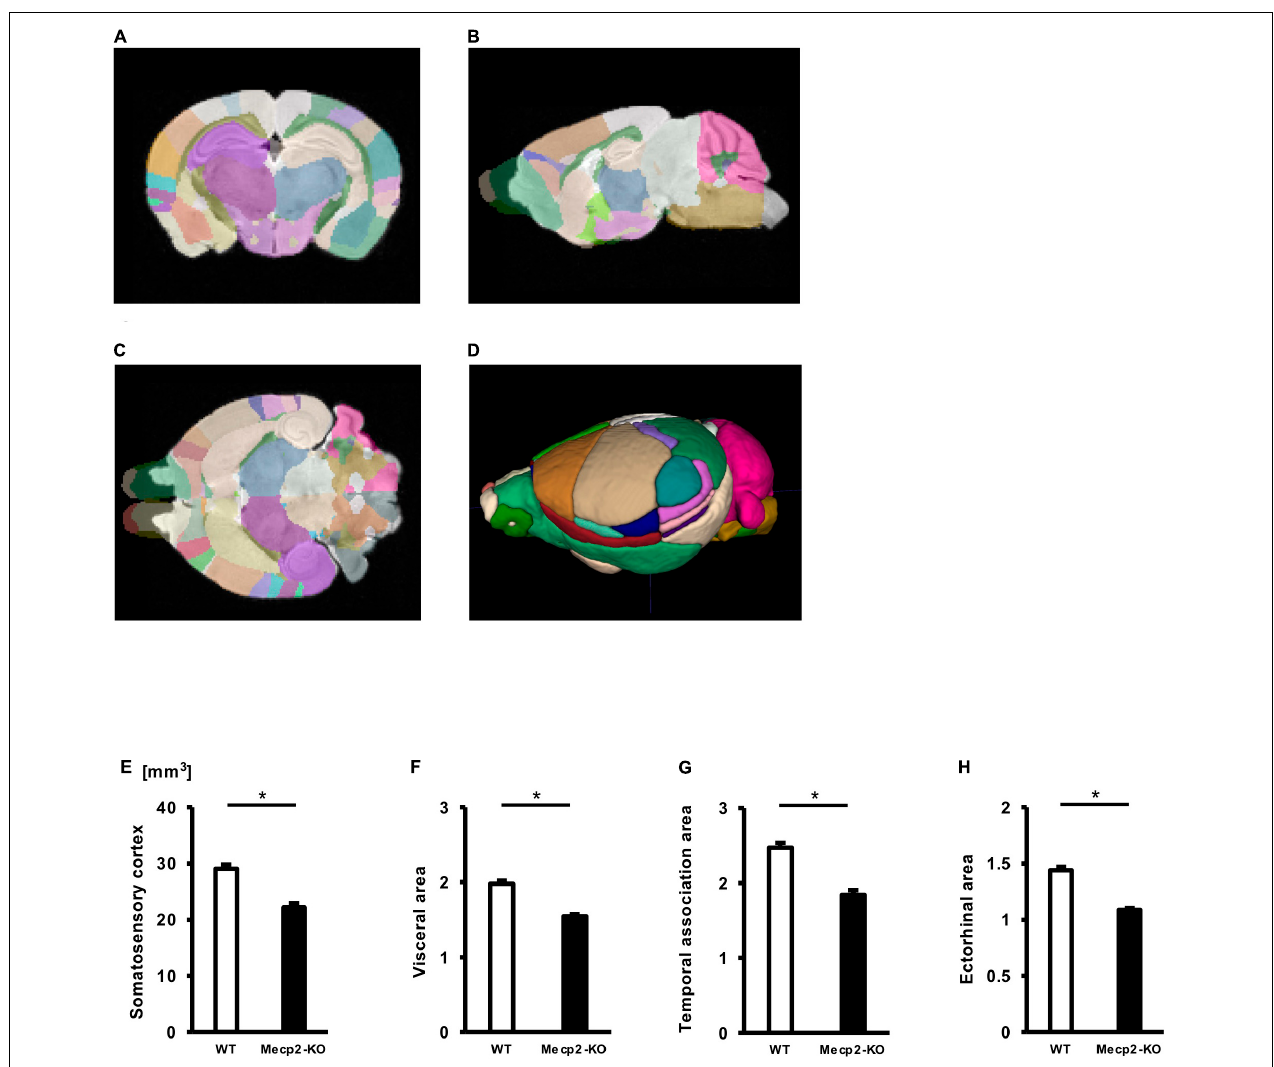
FIGURE 2 | Comparison between brain region volumes of WT and Mecp2 -KO mice obtained using volume-based morphometry. Atlas registration and quantification of anatomical regions in WT mice and Mecp2 -KO mice were performed using volume-based morphometry (A–D) . Several regional brain volumes in Mecp2 -KO mice compared with WT mice were significantly decreased, including the somatosensory cortex (E) , visceral area (F) , temporal association area (G) , and ectorhinal area (H) . Statistical test: Welch’s t -test. n = 4 mice per group. *Significant